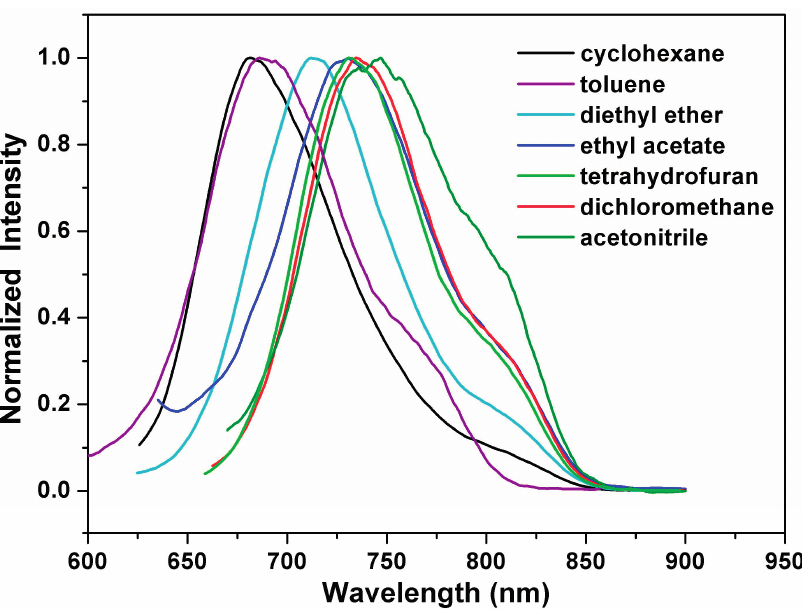
Figure 4. Normalized emission spectra of 1a in various